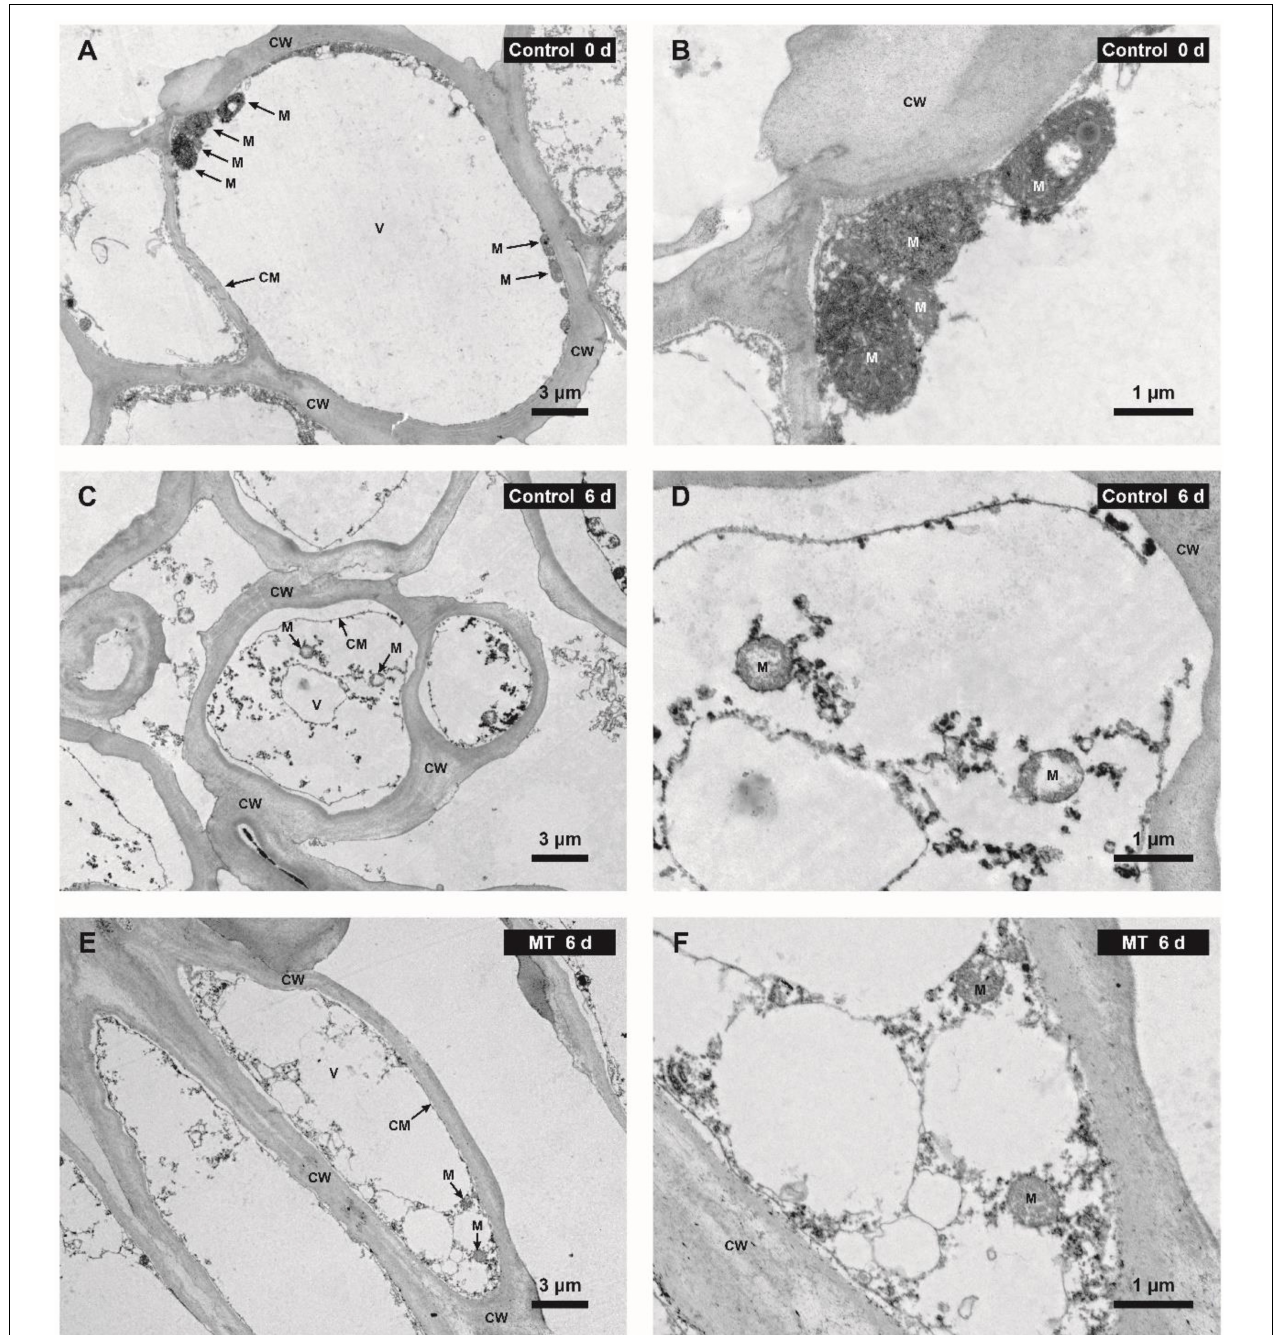
FIGURE 9 | Ultrastructure of the pericarp cells in control (water) and MT-treated in “Baoyan 7” rambutan fruit at 0 and 6 days of storage. × 1,200 magnification for (A,C,E) ; × 5,000 magnification for (B,D,F) . CW, CM, M, and V are abbreviations for the cell wall, cell membrane, mitochondrion, and vacuole, respectively.